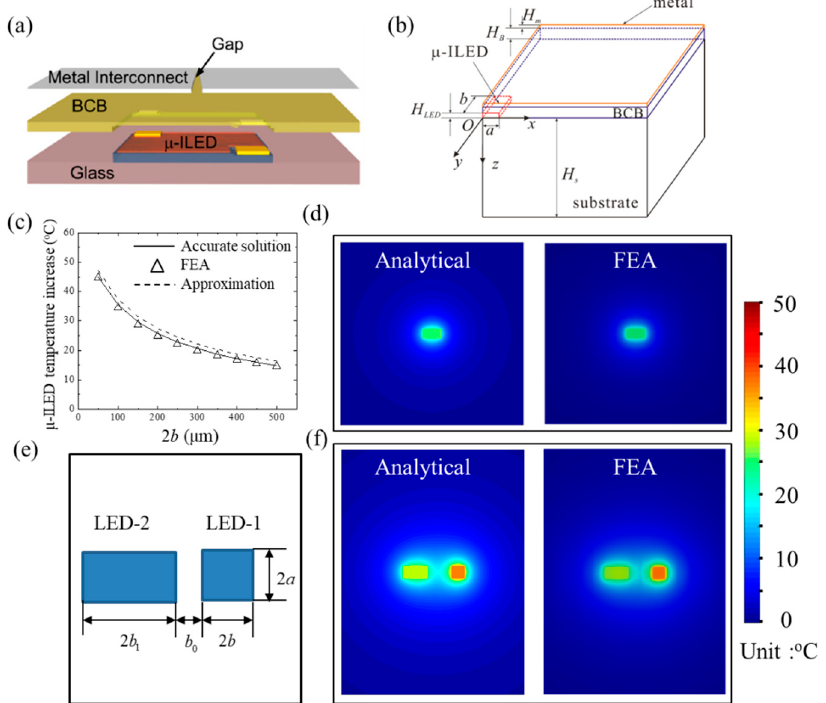
Figure 2. Schematic illustration of ( a ) the µ -ILED layout and ( b ) a quarter geometry of the analytical modeled µ -ILED system [54]. ( c ) The shape influence on the temperature increase of µ -ILEDs with 100 µ m × 2 b × 5 µ m under the input power of 12 mW [54]. ( d ) The distribution of the surface temperature increase of a single rectangular µ -ILED under the heat generation power 12 mW [54]. ( e ) Schematic diagram and ( f ) the distribution of surface temperature increase of a µ -ILED array consisting of two µ -ILEDs